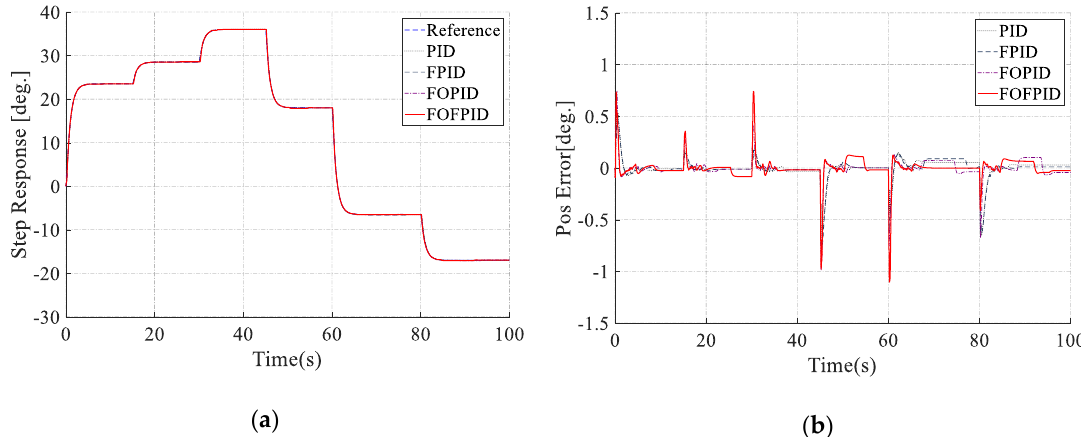
Figure 16. Comparison for multi-step trajectory (cutoff frequency 9 Hz and the payload is 50 N). ( a ) Output performance; ( b ) error effort.